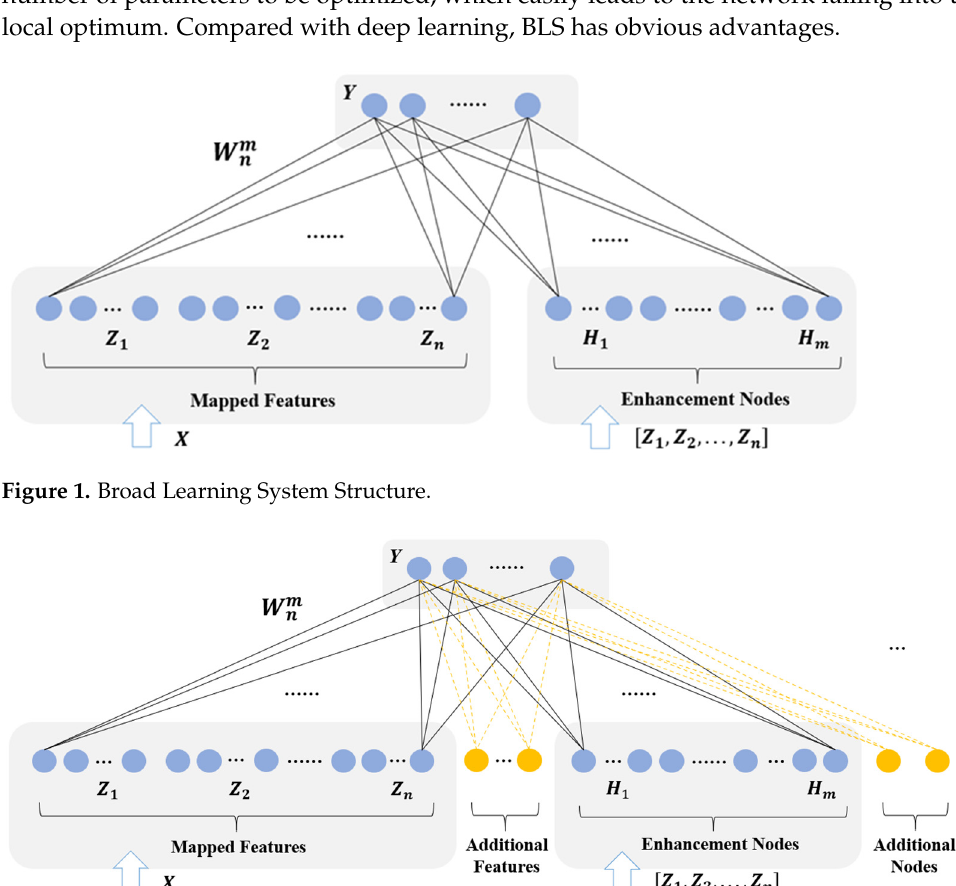
Figure 2. Structure of the Broad Learning System with Incremental Learning.